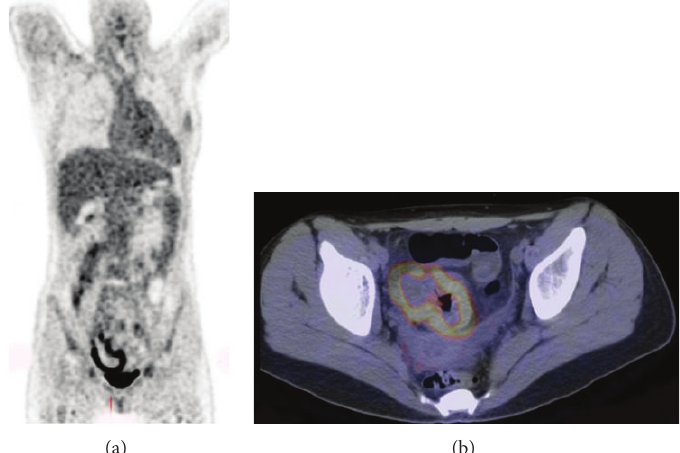
Figure 4: A 14-year-old girl known with Crohn’s disease. FDG-PET/CT (left: MIP image of the FDG-PET, right: fused FDG-PET/CT transaxial slice) showed inflammation of the